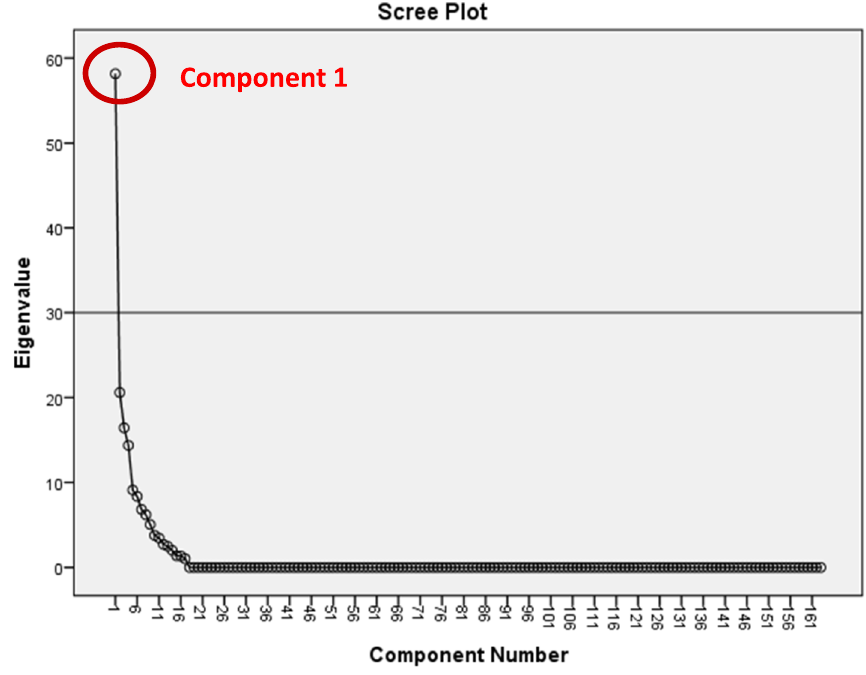
Fig. 8 Scree plot for the first runs (national variables)